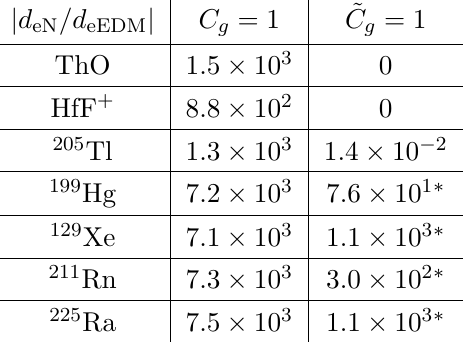
Table 3 . Estimate of the ratio of the contribution from CP-odd electron-nucleon interaction to the contribution of direct electron EDM in benchmark scenarios described in the text. The numbers should all be viewed as rough estimates. For entries marked with an asterisk, the ratio might be signi(cid:12)cantly overestimated, considering the large uncertainties shown in table